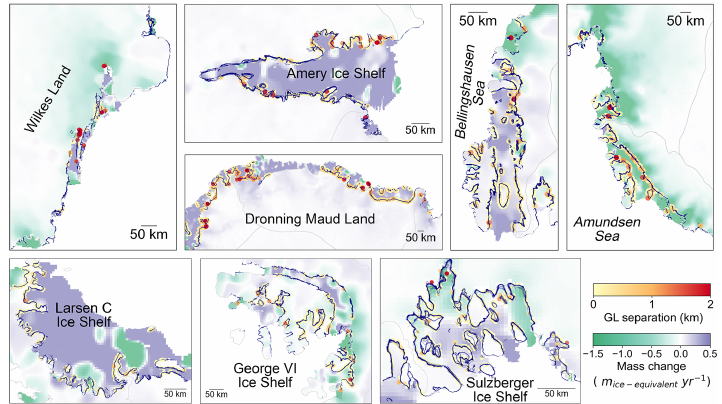
Figure A3. Spatial distributions of the absolute separations between the ICESat-2-derived landward limit of tidal flexure (Point F) and Sentinel-1a/b DInSAR-derived Point F in 2018 of individual regions in Table 2; the spatial extents of each region are shown as black boxes in Fig. 8. In all subplots, data are superimposed over the recent mass change map (Smith et al., 2020b); the blue line is the Sentinel-1a/b DInSAR-derived Point F in 2018 (Mohajerani et al., 2021), and the light-grey line is the IMBIE basin boundary (Shepherd et al., 2018; Rignot et al., 2011b).